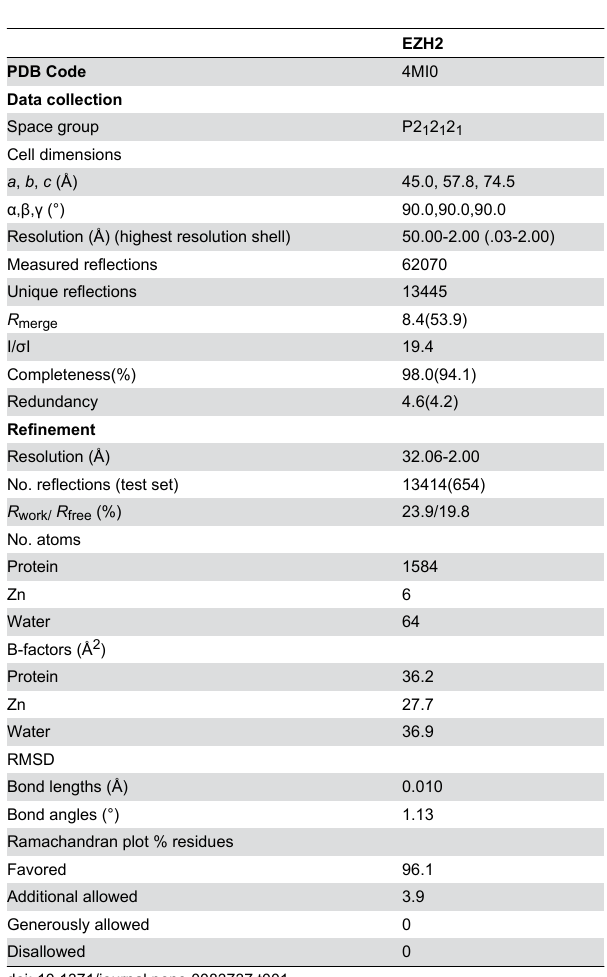
Table 1. Crystallography data and refinement